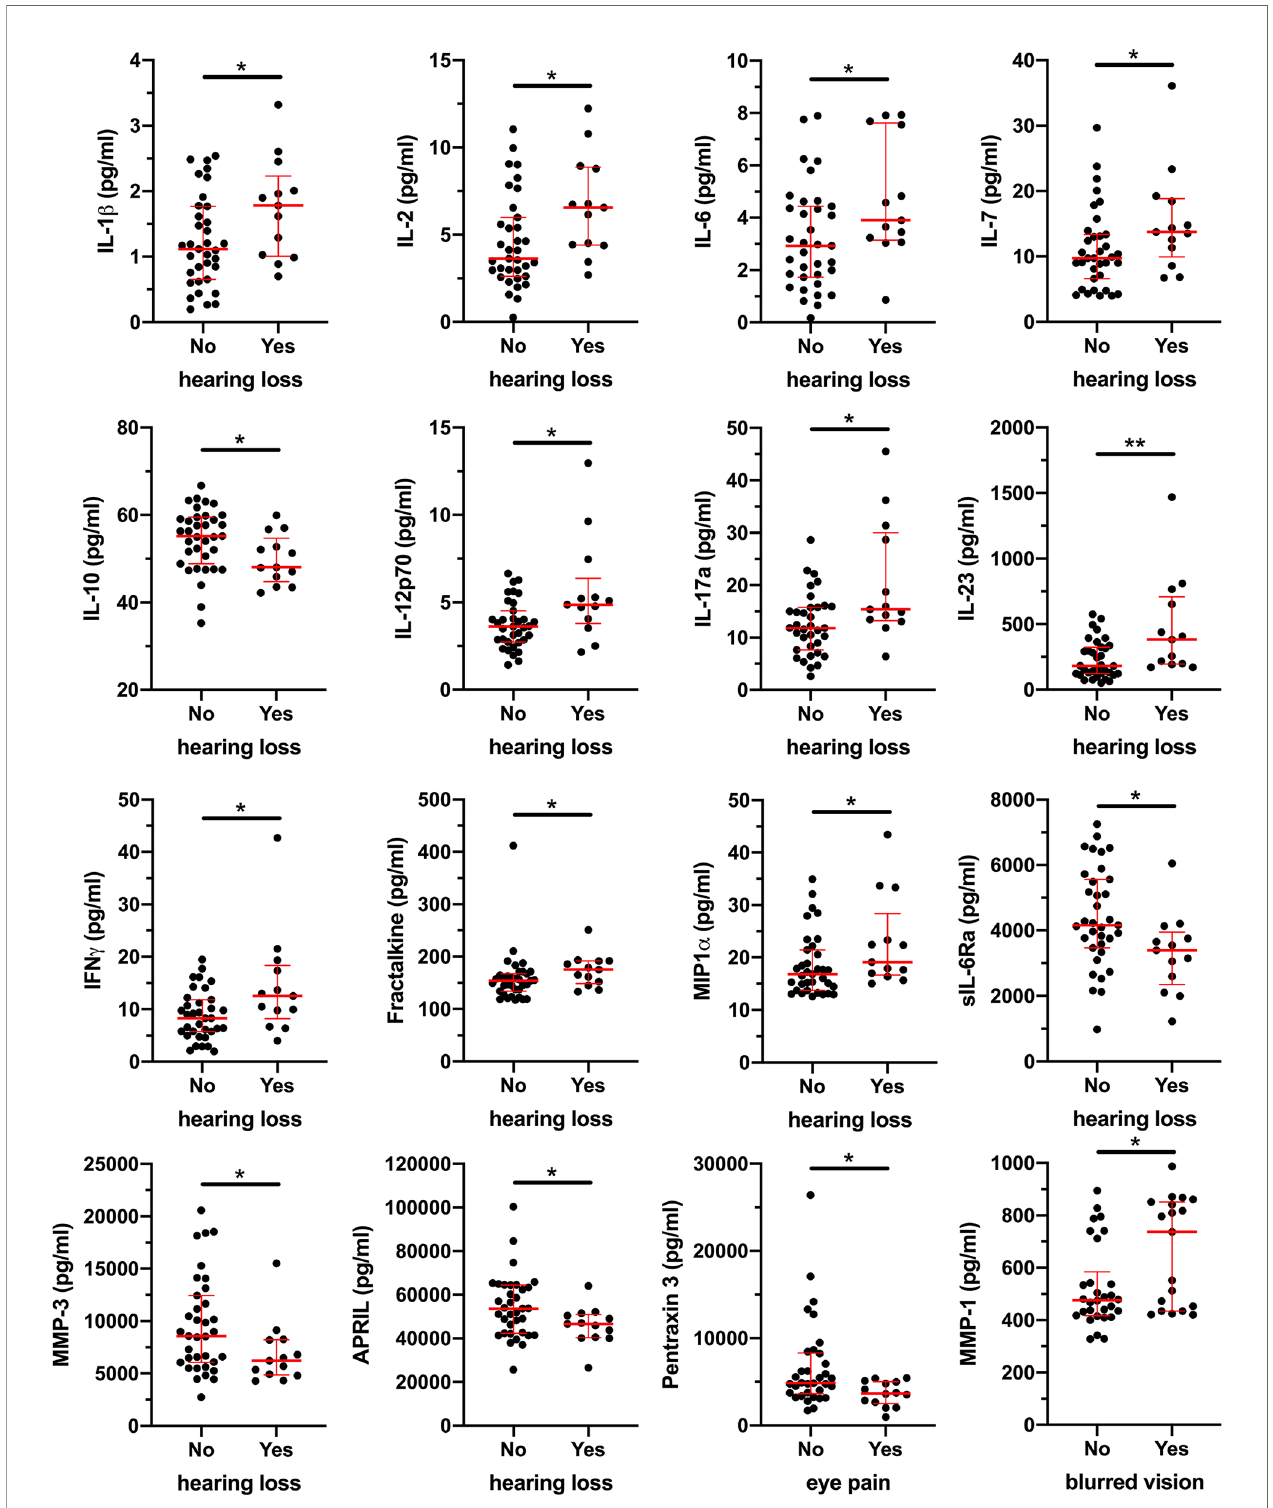
FIGURE 3 | Elevated plasma levels of pro-in fl ammatory soluble factors in BDBV survivors with hearing loss. Plasma levels of 53 soluble factors were measure by Luminex and results were compared between BDBV survivors with or without long term sequalae. Signi fi cant differences are shown for IL-1 b , IL-2, IL-6, IL-7, IL-10, IL-12p70, IL-17a, IL-23, IFN g , Fractalkine, MIP1 a , sIL-6Ra, MMP-3, and APRIL for hearing loss as well as Pentraxin 3 and MMP-1 for eye pain and blurred vision respectively. The line and whiskers represent the median and interquartile range respectively. ** represents p values < 0.01 and * represents p values <